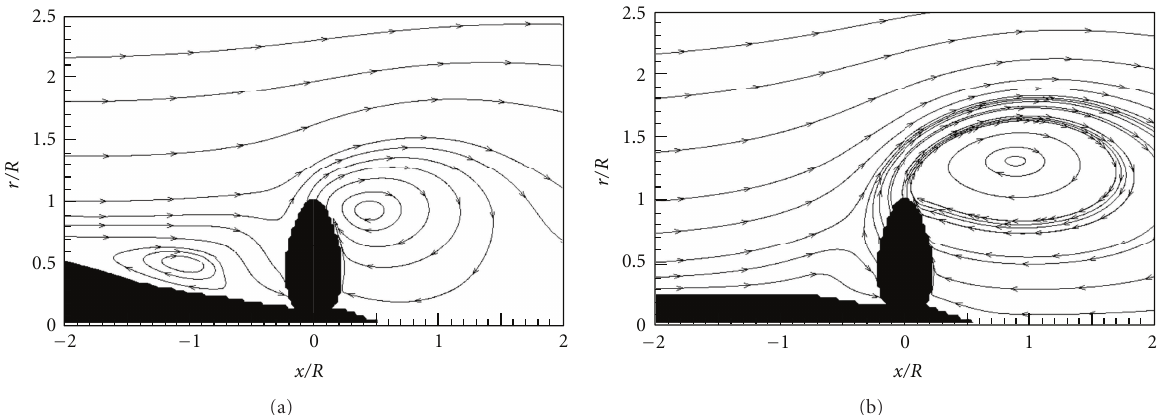
Figure 10: Circumferentially averaged streamlines at J = − 1 . 0: (a) w/ hull, (b) w/o hull.